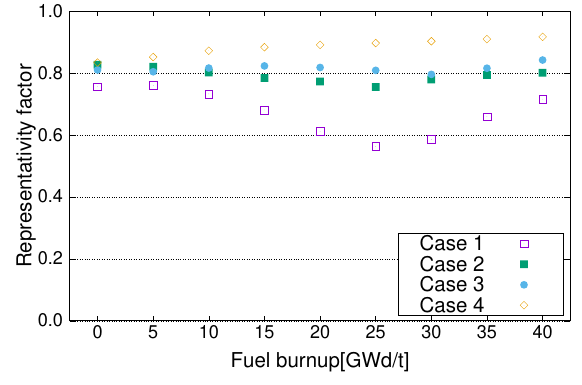
Figure 1. Total and component-wise nuclear data-induced un- certainty of k ∞